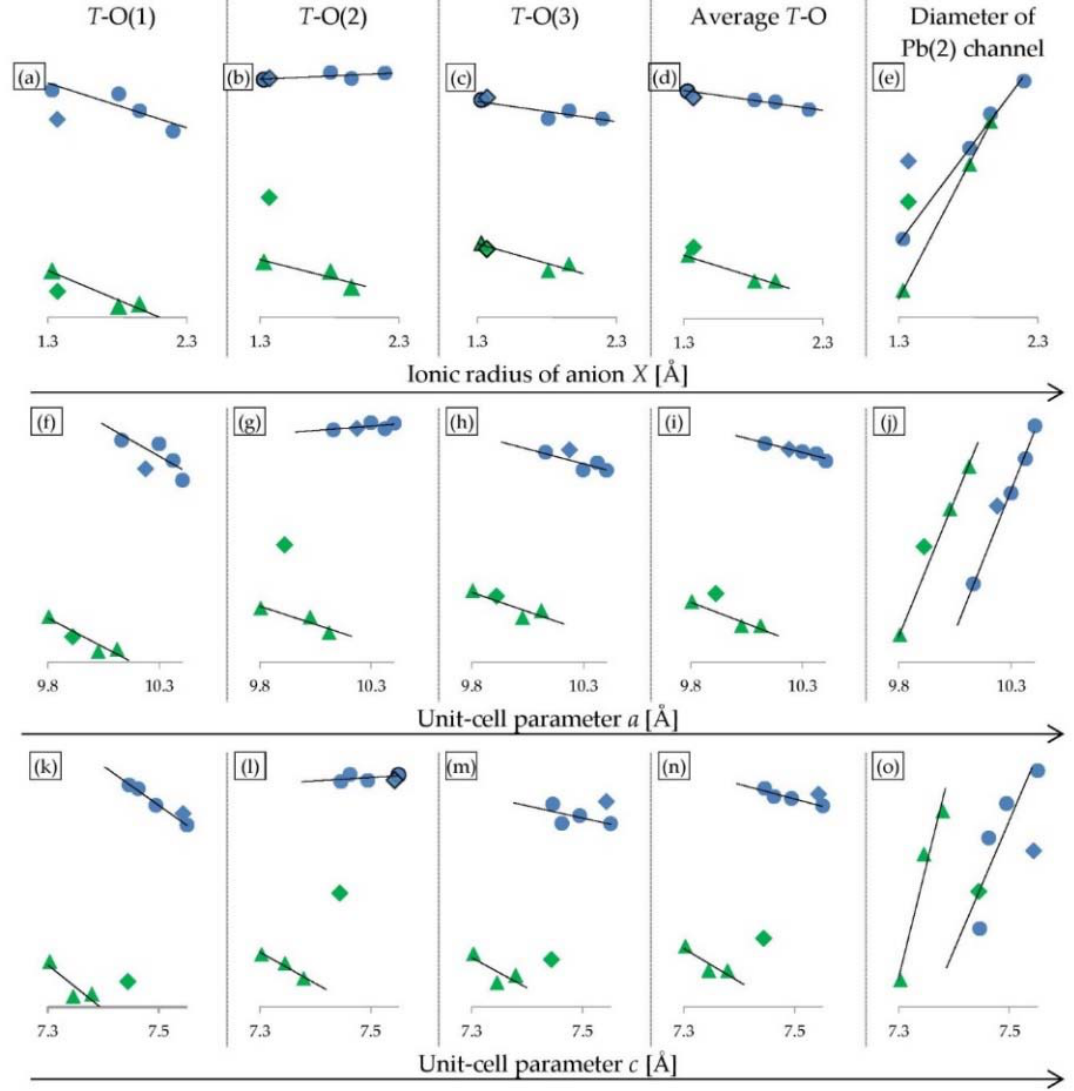
Figure 6. Selected correlations of interatomic distances for halogenated mimetites from this study (blue dots) and halogenated pyromorphites reported by Kim et al. [11] (green triangles). All OH-phases are marked by diamonds: mimetite-OH from this study (blue), and pyromorphite-OH reported by Kim et al. [11] (green). Descriptions in each column head correspond to the vertical axes, and the values are intentionally omitted to highlight the trends within the series (interatomic distances for the mimetite series can be found in Table 3). The horizontal axes are: ( a – e ) ionic radius of anion X ; ( f – j ) unit-cell parameter a ; ( k – o ) unit-cell parameter c . Ionic radius of anion X as well as the unit-cell parameters a and c increase in the mimetite series F-Cl-Br-I and in the pyromorphite series F-Cl-Br from left to right.